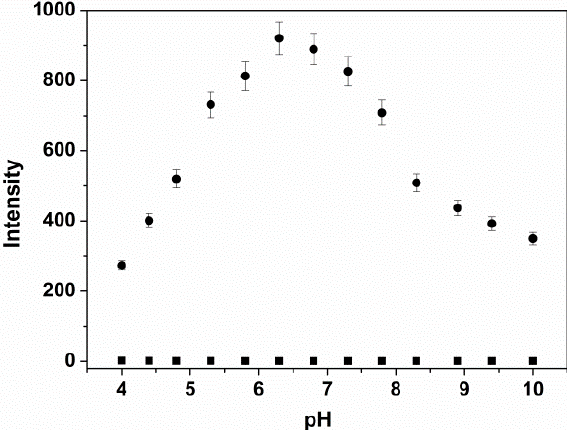
Figure 1. pH-dependent fluorescence response of P (10 µM) and P (10 µM) toward Cu 2+ (100 µM) under different HEPES buffers.